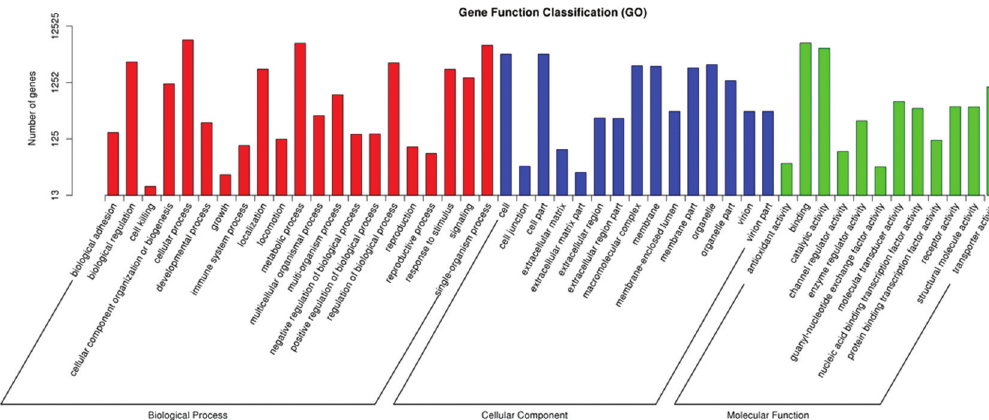
Figure 2 - Gene ontology classifications of unigenes from the P transcriptome.